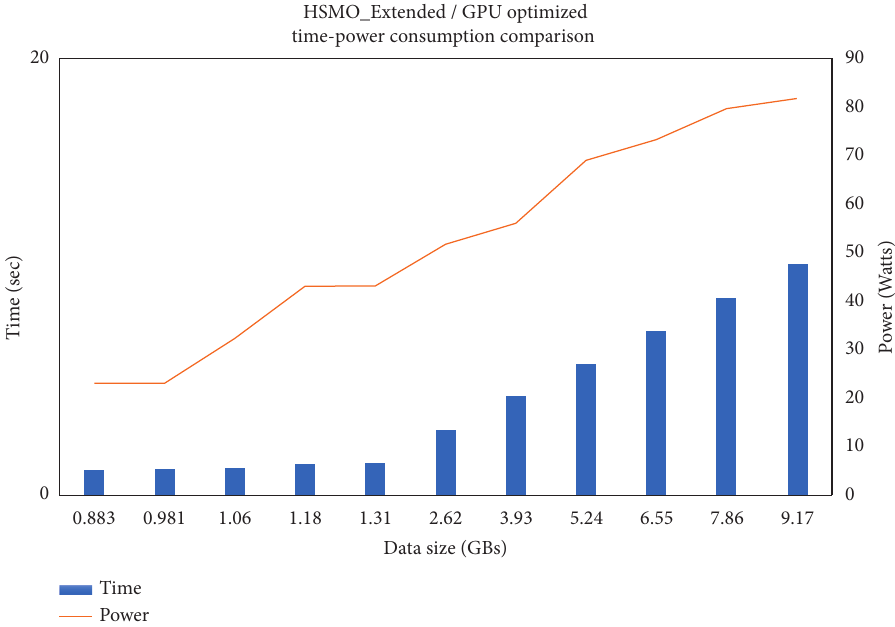
Figure 14: HSMO_Extended/GPU optimized—time-power consumption comparison.